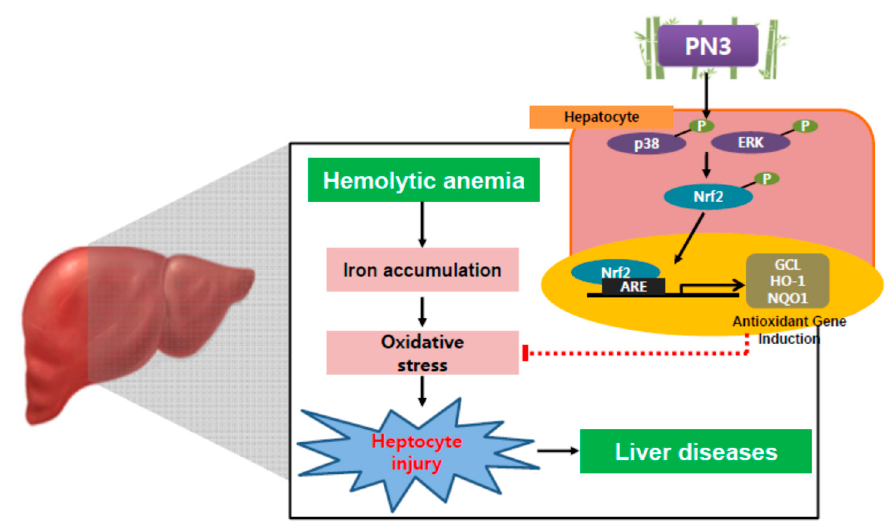
Figure 8. Schematic diagram illustrating the mechanism by which the PN3 protected the cells against iron overload-induced liver injury.